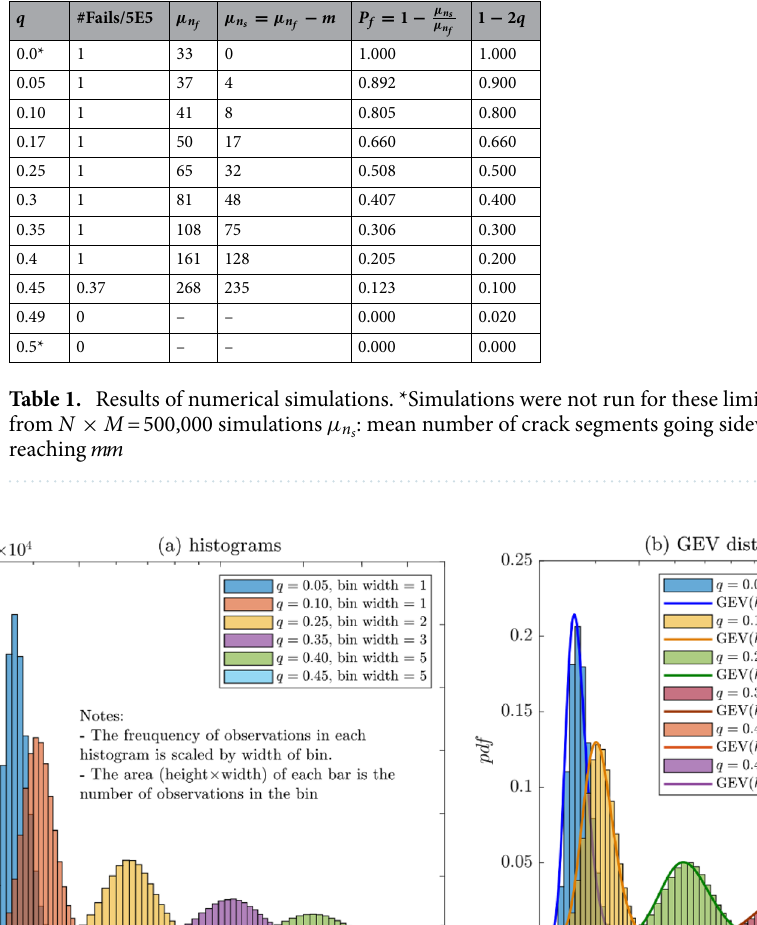
Figure 18. ( a ) n f histograms and ( b ) GEV distribution fitting for different values of the probability q